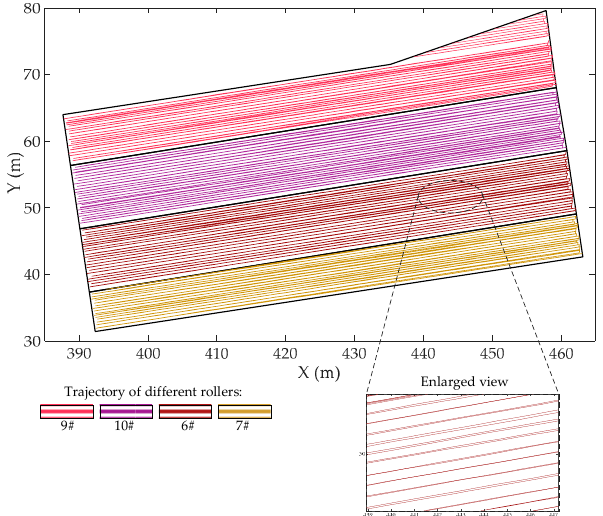
Figure 6. The actual roller trajectory of the simulated layer obtained from the intelligent compaction construction monitoring system.